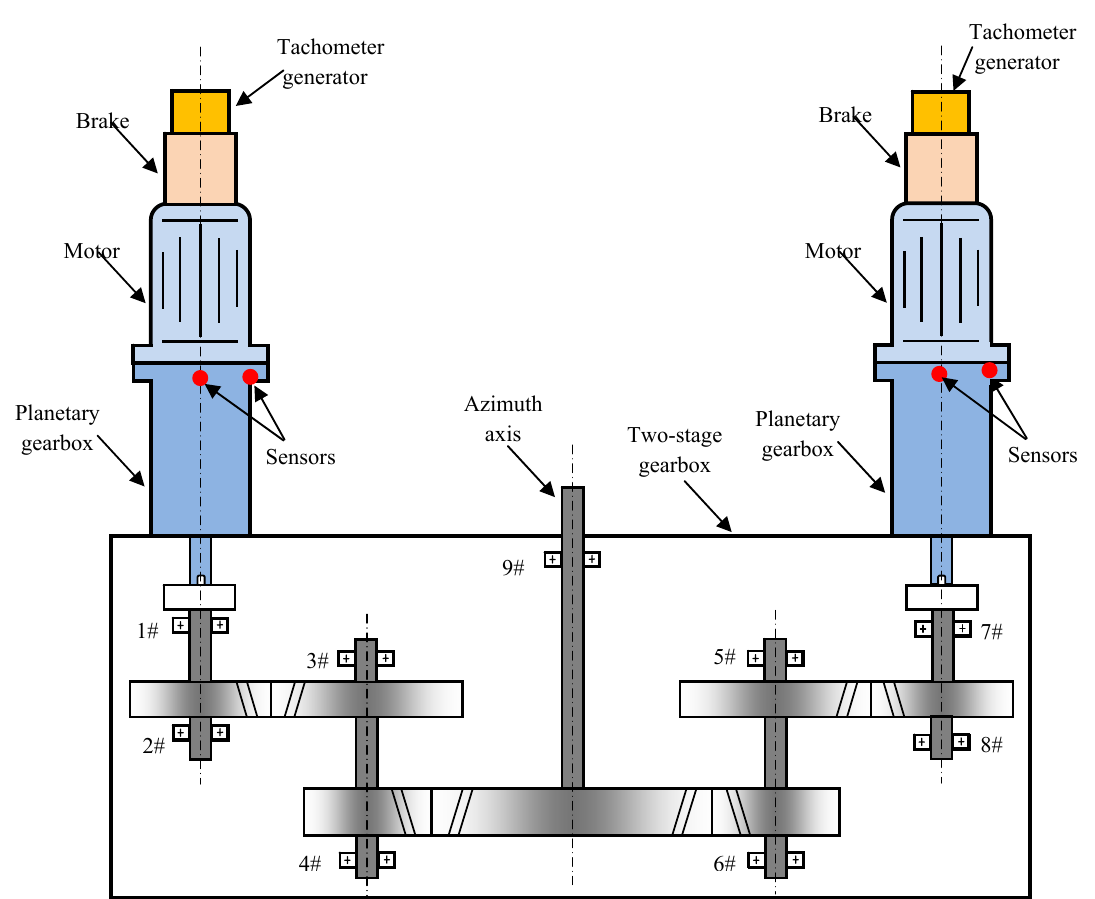
Figure 8. The transmission mechanism of the azimuth